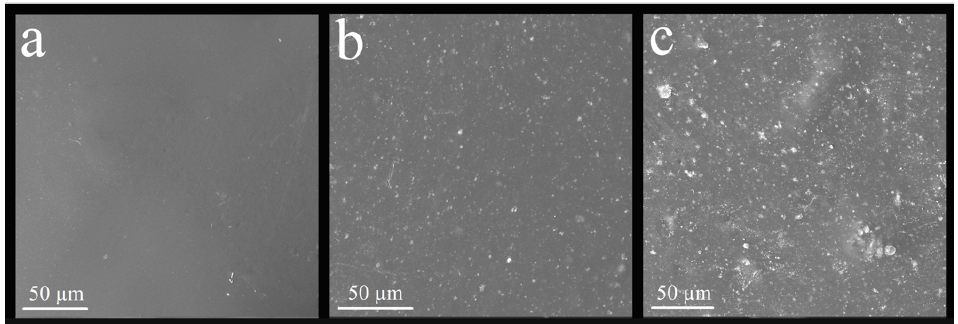
Figure 6. Images obtained by SEM-EDX of the surface of the nanocomposites of the experimental groups relative to the glaze: ( a ) group CG, ( b ) group G1, and ( c ) group G2.